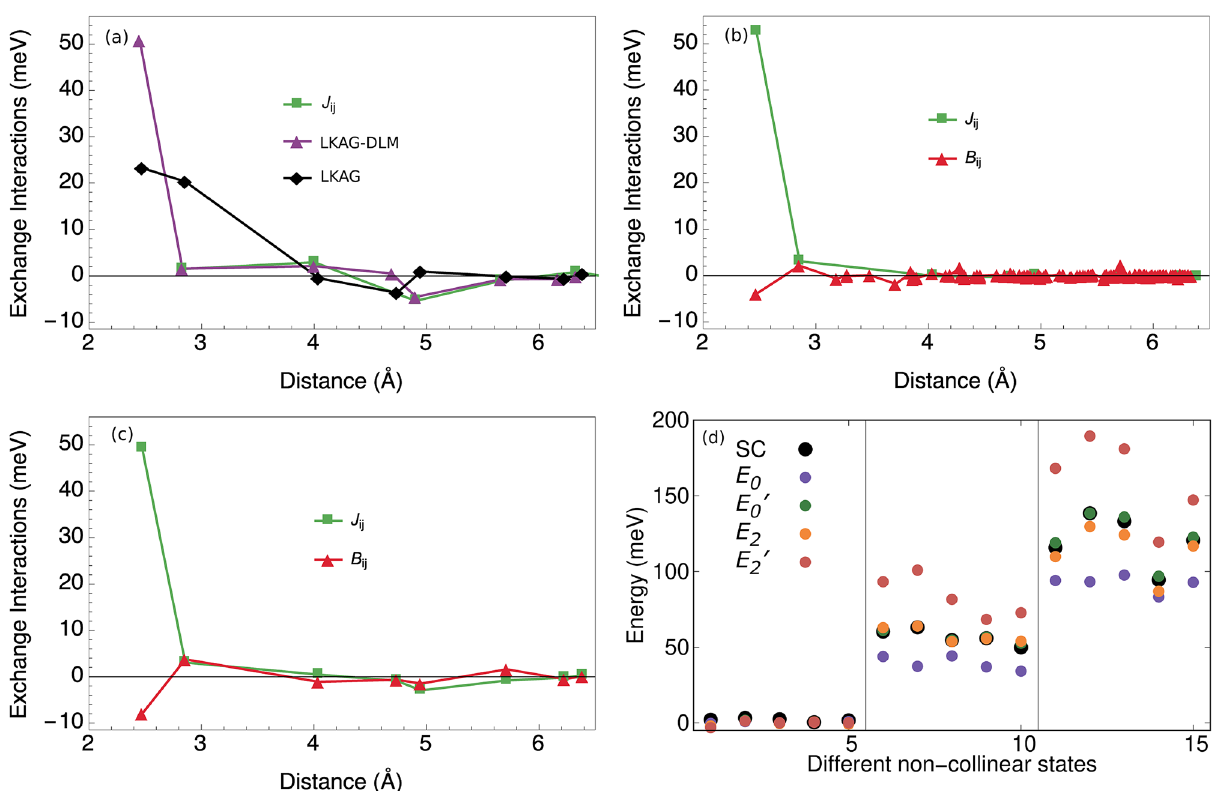
Figure 6. The parameterisation of three different models are shown for bcc Fe. ( a ) shows the result for the H 0 model together with exchange parameters calculated using Lichtenstein et al. 9 method, with and without the DLM formalism. ( b ) and ( c ) shows the result for the H 2 and H 1 models respectively. For the H 2 and H 1 models, the sums of the distances between the moment-quadrupoles are divided by four in order to make the distances of the exchange parameters J ij comparable with the B ijkl . ( d ) Total energy for a set of different non-collinear states with increasing cone-angle towards the right. For each cone-angle, there are five different configurations with random azimuthal